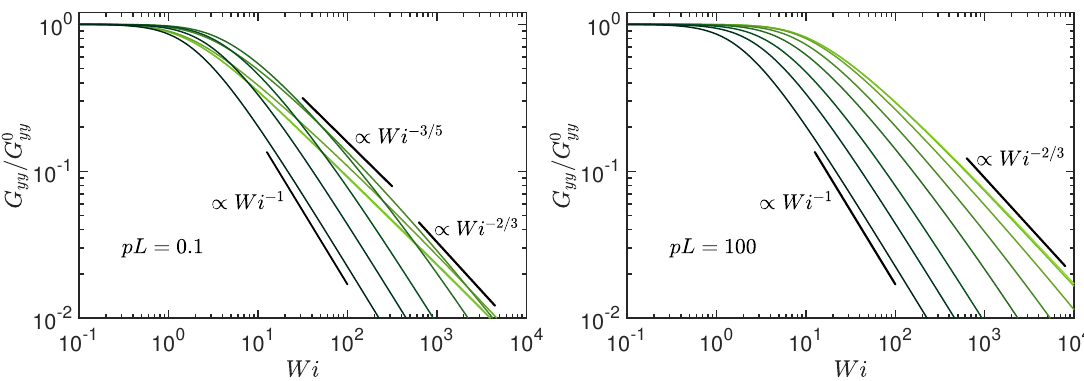
Figure 7. Radius of gyration-tensor component G yy along the gradient direction normalized by the value G 0 yy at zero shear as function of the Weissenberg number Wi for the Péclet numbers Pe = 0, 0.6, 3, 10, 30, 10 2 ,3 × 10 2 , and ∞ (bright to dark color); ( left ) pL = 0.1 and ( right ) pL = 10 2 . The number of active sites is L / l = 10 2 and ∆ =